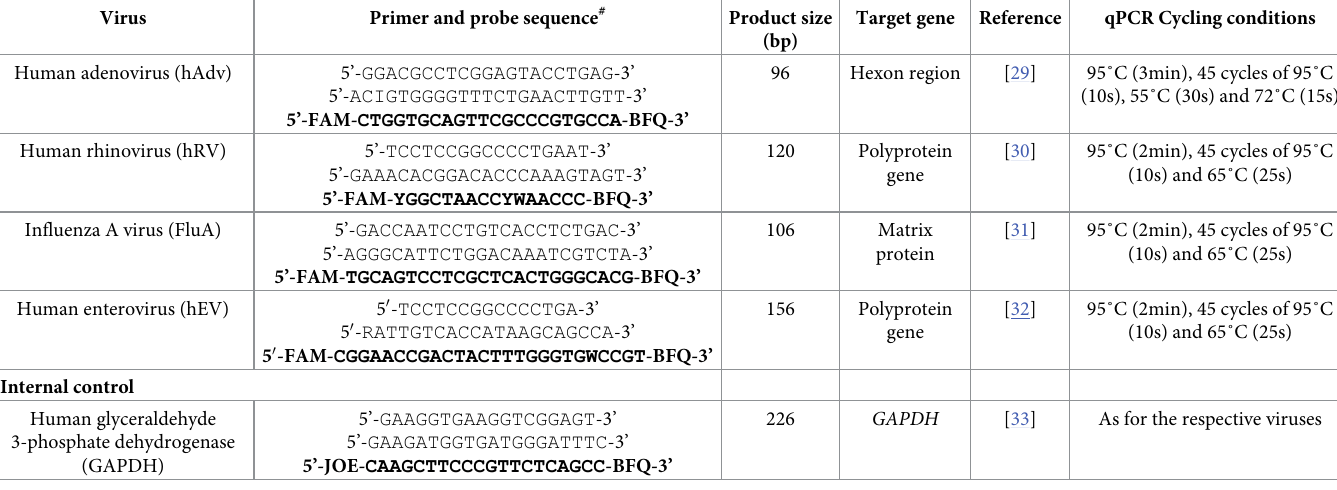
# Probe sequences are indicated in